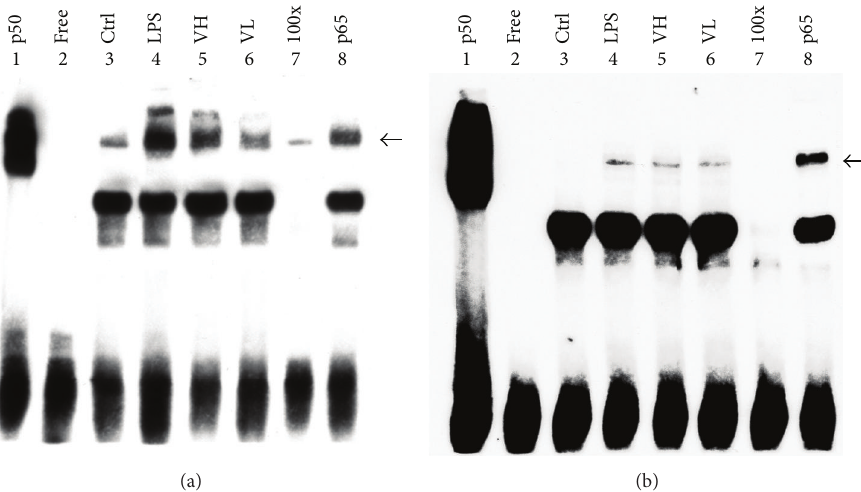
Figure 9: Electrophoretic mobility shift assay to study DNA-binding activity. Electrophoretic mobility shift assay was performed to study the DNA-binding activity of NF- 𝜅 B in the ICB of EIU rats (a) and in RAW 264.7 cells treated with LPS (b). The results showed that the DNA-binding activity increased in the LPS group, and treatment with bortezomib effectively lowered the NF- 𝜅 B activity. Lane 1: p50 subunit of NF- 𝜅 B. Lane 2: free probe. Lane 3: control group. Lane 4: LPS-treated group. Lane 5: LPS with high-dose bortezomib. Lane 6: LPS with low-dose bortezomib. Lane 7: competition with 100x unlabeled NF- 𝜅 B probe. Lane 8: anti-p65 antibody supershift